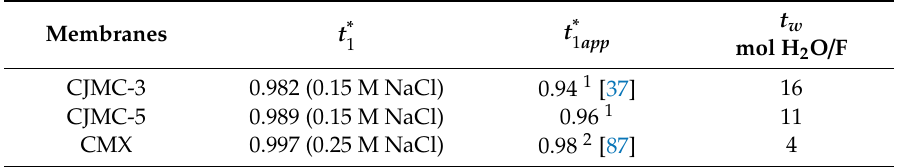
Table 3. The values of the “true” ( t ∗ transport number ( t w ) in the studied membranes. water transport number (